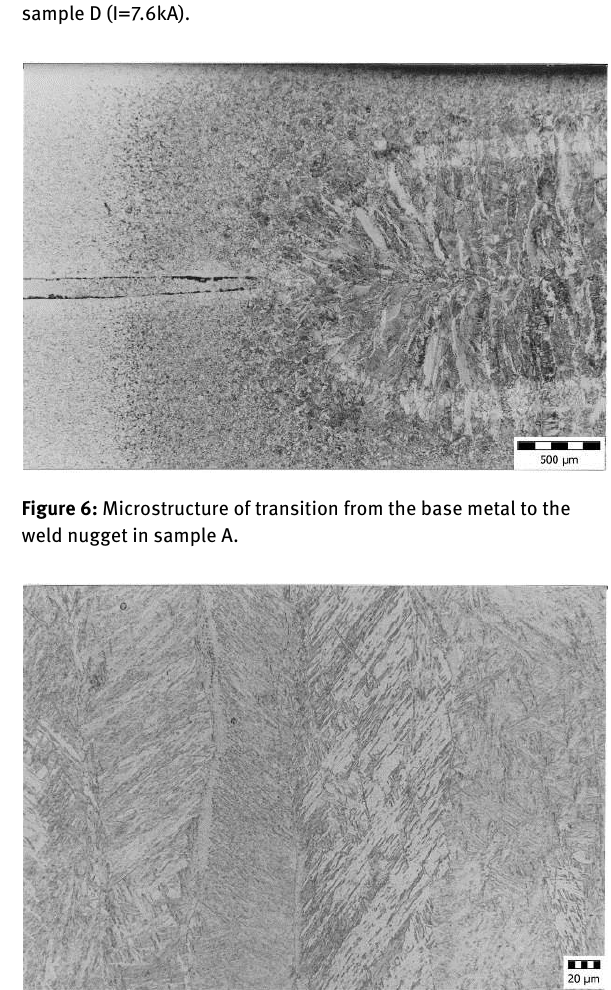
Figure 5: Macrostructures of the welds of H260 LAD steel: a) sample A (I=6.0kA), b) sample B (I=6.6kA), c) samples C (I=7.0kA) and d) sample D (I=7.6kA).